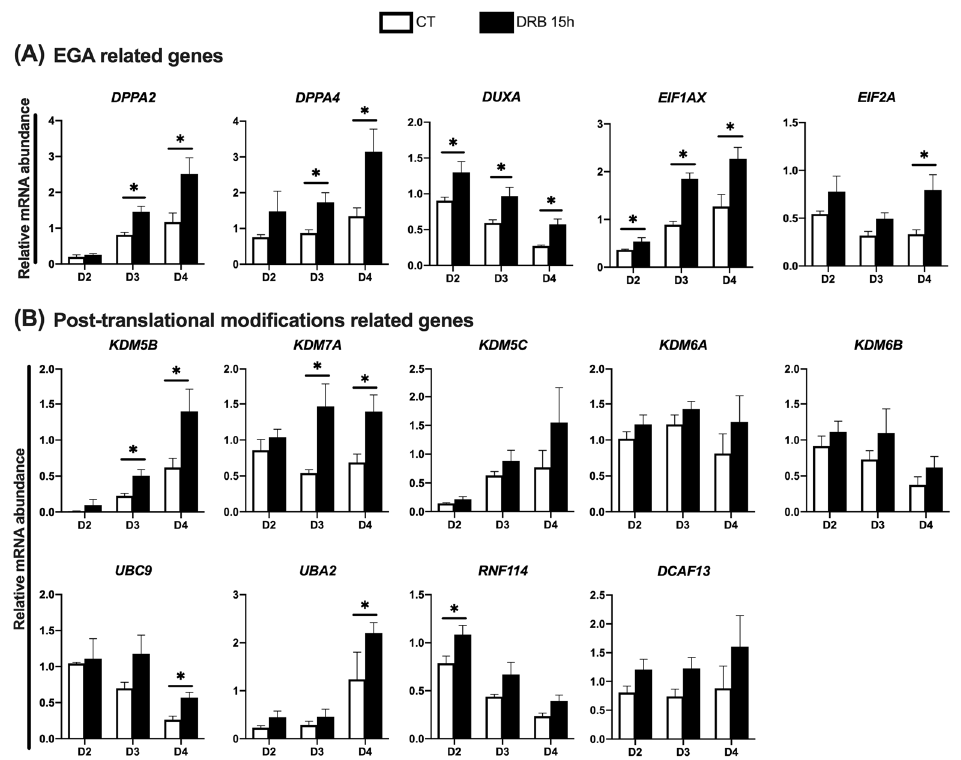
Figure 4. Relative abundance of transcripts at different days of development in SCNT embryos that were treated with Scriptaid (CT) or Scriptaid + DRB for 15 h after nuclear transfer. ( A ) Genes involved in the EGA and ( B ) gene involved in post-translational modifications. A total number of 10 to 15 embryos were collected per replicate (n = 3) and treatment for each day of development. Asterisks indicate statistical difference between treatments in the same day of development (* p < 0.05).